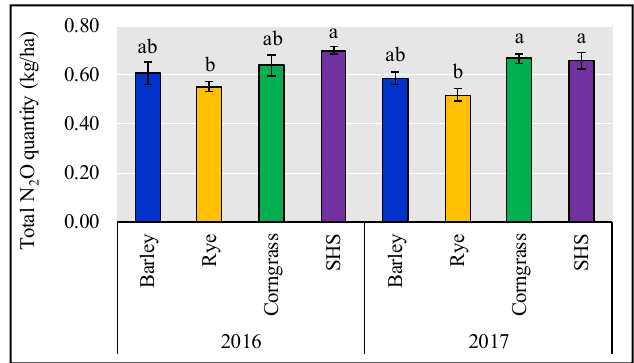
Figure 3. The total soil N 2 O flux from barley, rye, SHS, and corngrass fields during growing seasons in 2016 and 2017. Means with the same letters are not significantly different ( P > 0.05).